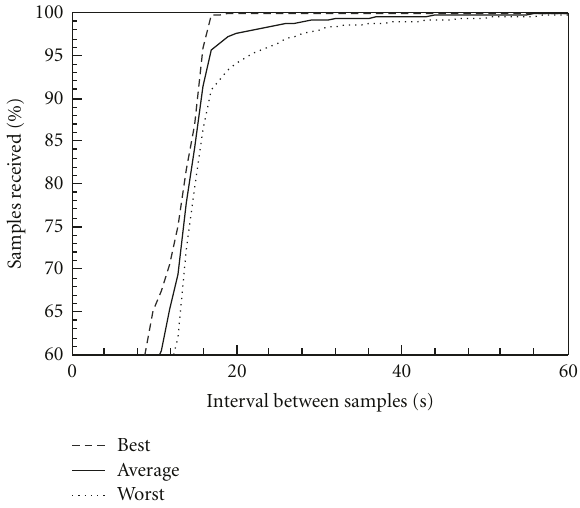
Figure 22: Availability of best, average, and worst case nodes in measurement